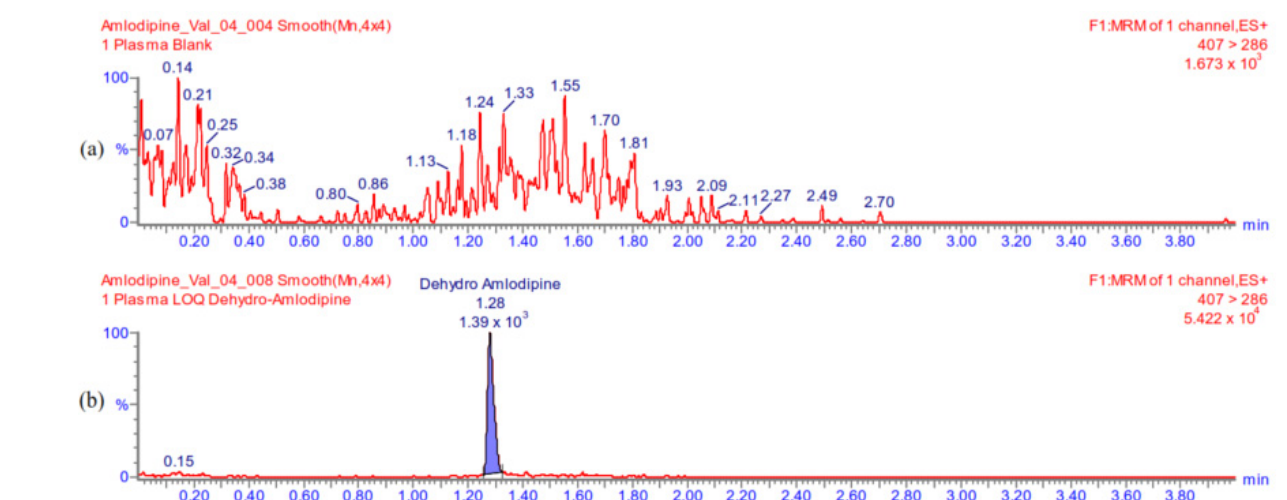
Figure A1. AML MRM chromatograms of human blood plasma source 1. ( a ) Blank plasma sample. ( b ) Plasma spiked with AML at 1.0 ng/mL.